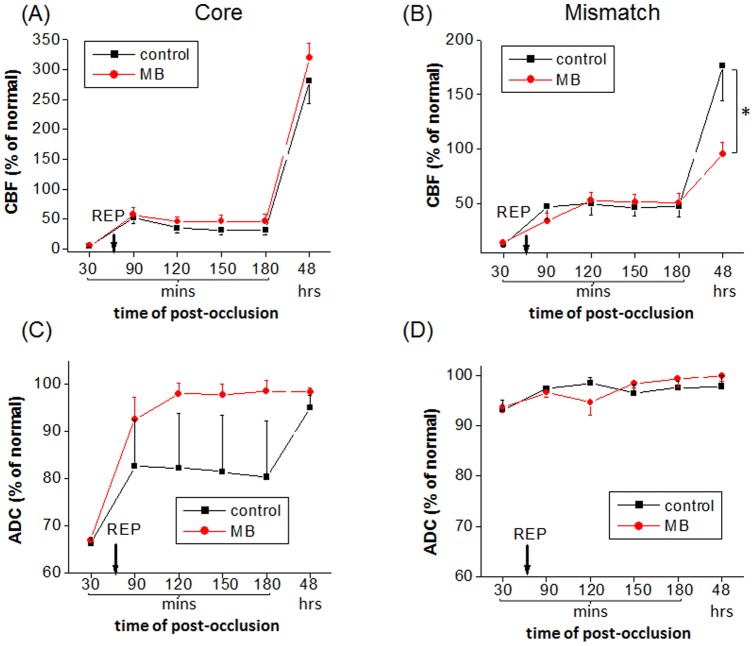
Normalized ADC and CBF values in acute phase and day-2 of core and mismatch tissues for control and MB-treated groups.Core and mismatch tissues were determined based on pre-reperfusion (30-min) data.